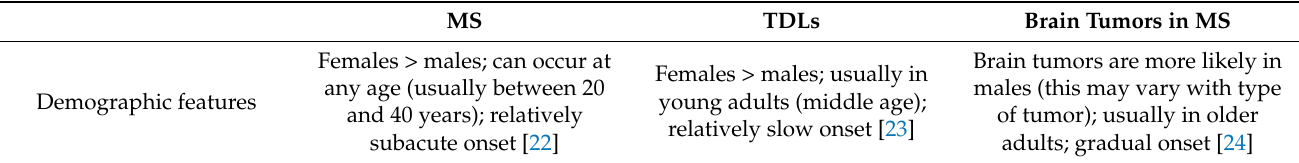
Table 3. Differential diagnosis of MS, TDLs, and brain tumors in MS.